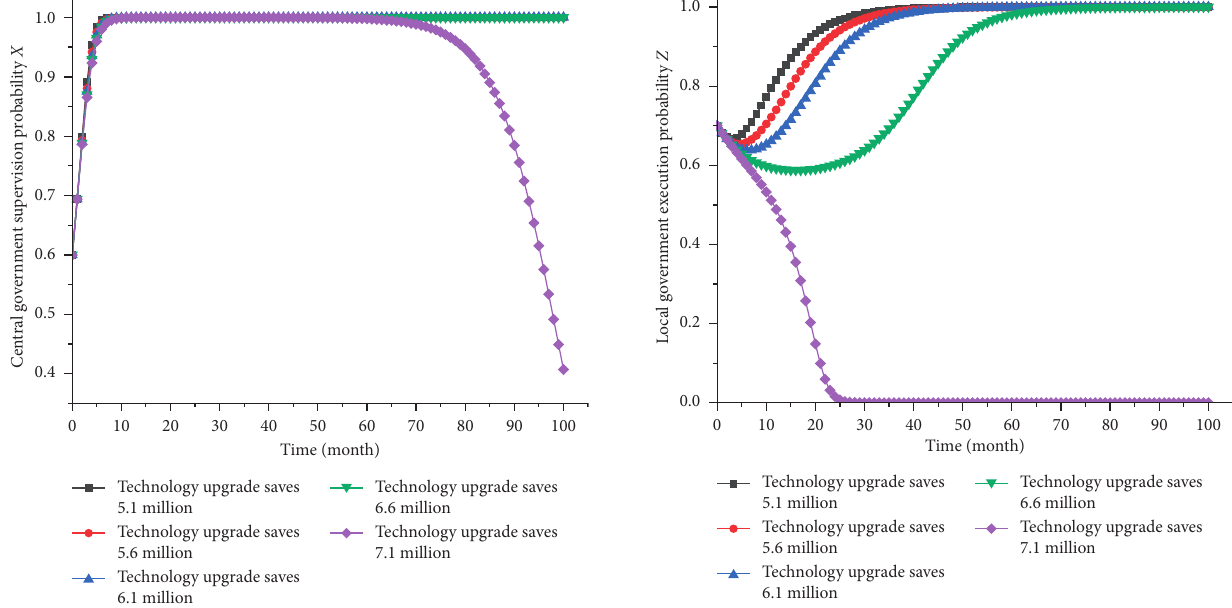
Figure 6: Impact of technology upgrade cost savings on central government strategy choices.